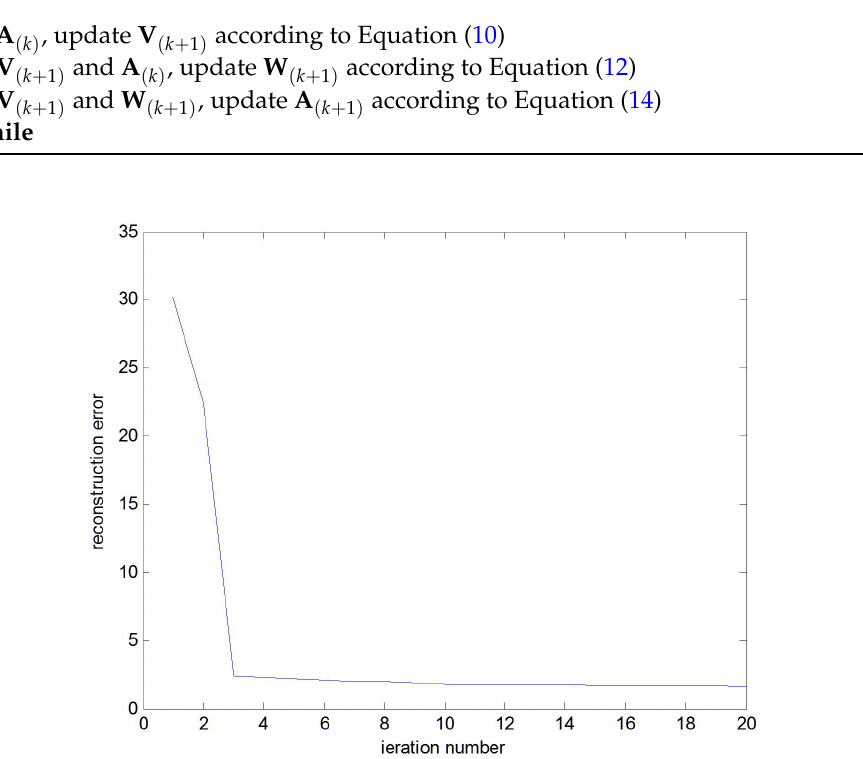
Figure 6. The representative reconstruction error of the objective